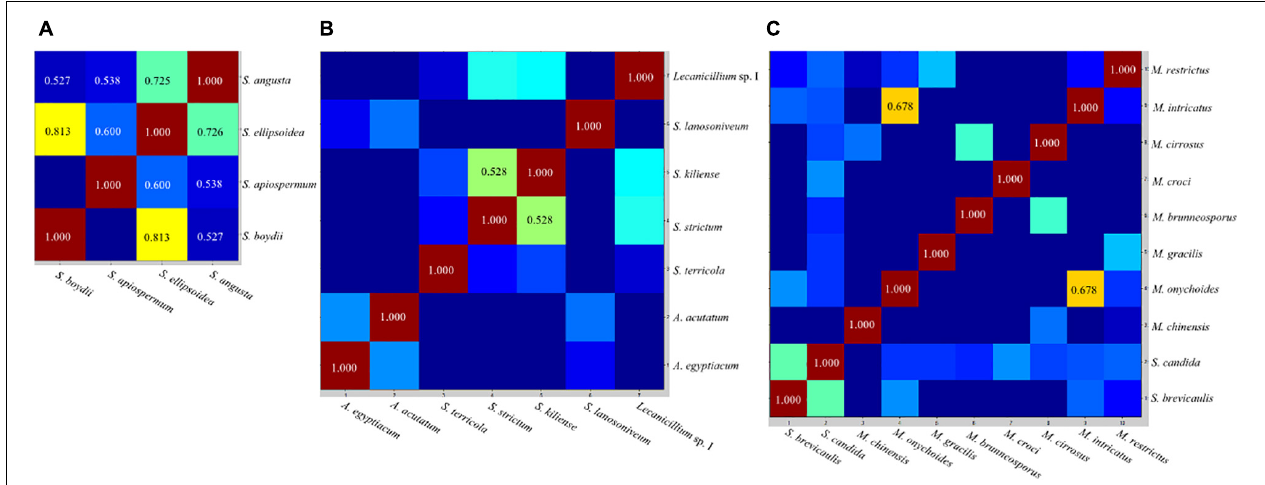
FIGURE 4 | Representative composite correlation index (CCI) matrix derived from Scedosporium (A) , Acremonium -like (B) , Scopulariopsis and Microascus species (C) . By comparing the spectra of different species, numerical correlation index is obtained to form the CCI matrix and translated into a heat map. Closely related spectra were represented in hot colors and with higher CCI value, and unrelated spectra in cold colors with lower CCI value. CCI value ≥ 0.5 were shown in the view.